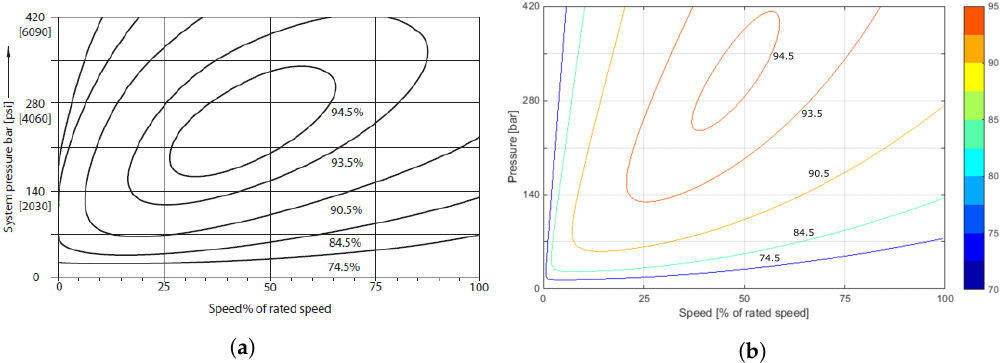
Figure 6. Efficiency map of the Sauer-Danfoss 250 cc Series 51-1 bent-axis motor, ( a ) measures provided by [38] and ( b ) the reproduction of the efficiency map using the model.